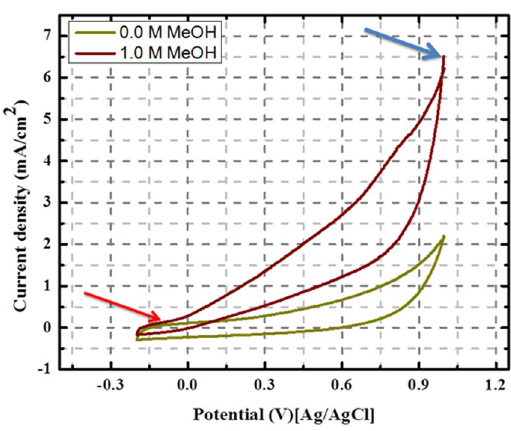
Figure 6. Cyclic voltammograms for the obtained core@shell (ZnO@C) microspheres in absence and presence of 1 M Methanol in 1 M KOH solution at the scan rate of 50